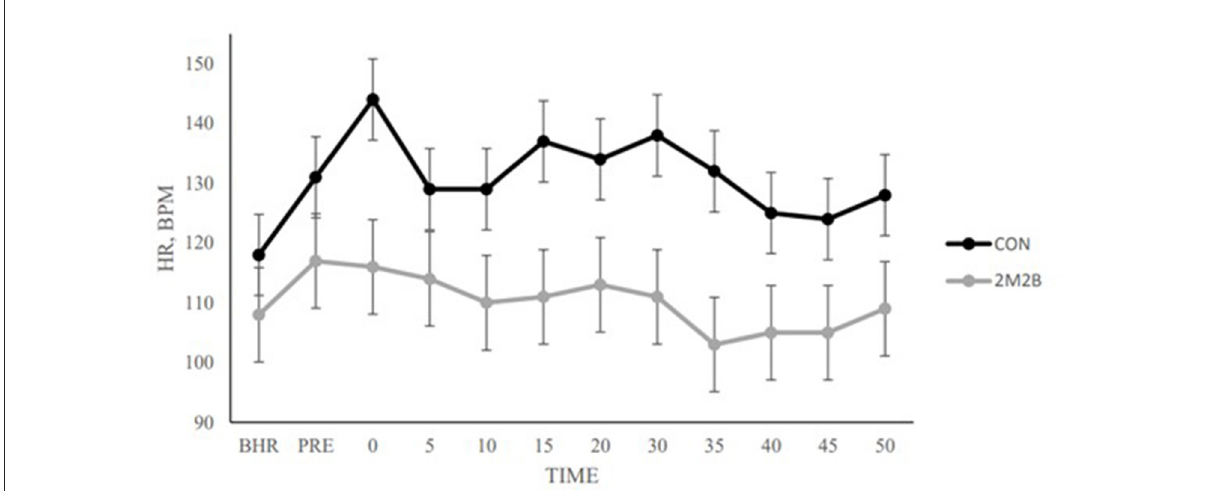
FIGURE1 Dog heart rate when dogs either had a control car trip or a car trip in which 2M2B was sprayed in the environment. Each data point represents 8 dogs. Note that dogs with 2M2B therapy had significantly lower heart rate than control dogs. Adapted from Pirner (28). BHR is basal heart rate. Pre is immediately before transport. Note that control dogs increase in HR at time zero and remain elevated during the trip. This is an objective demonstration of a calming effect.